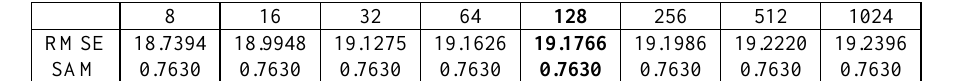
Table 1. CC between Worldview-2 multispectral and fused images using BR with different block size